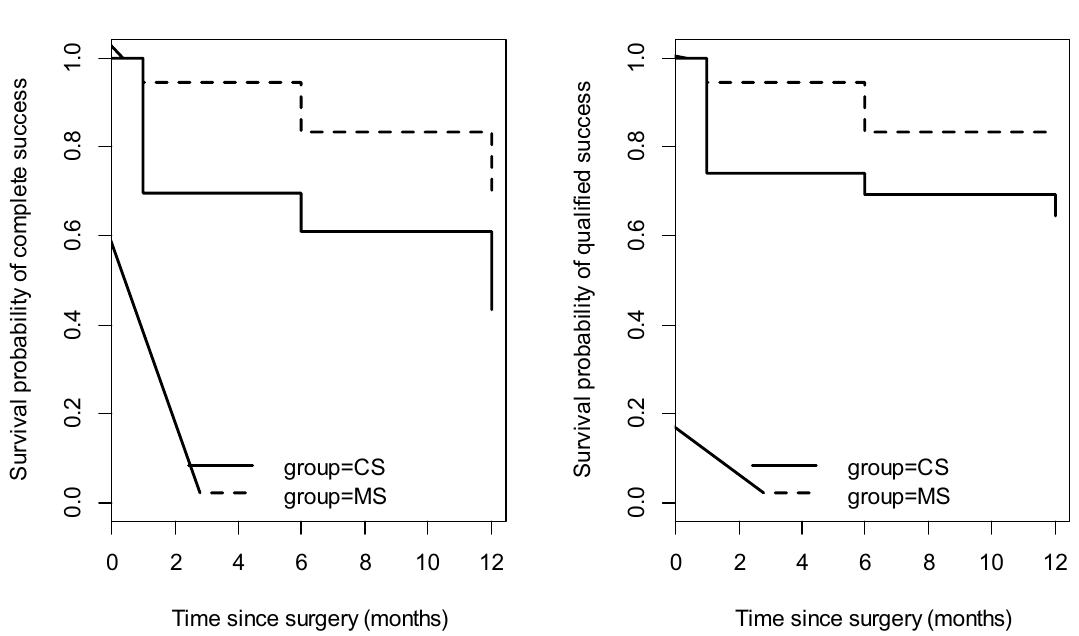
Figure 1. Survival curves illustrating the probability of complete success (IOP ≤ 18 mmHg without medications) and qualified success (IOP ≤ 18 mmHg with no more than two medications). CS corneal suture group, IOP intraocular pressure, MS muscle suture